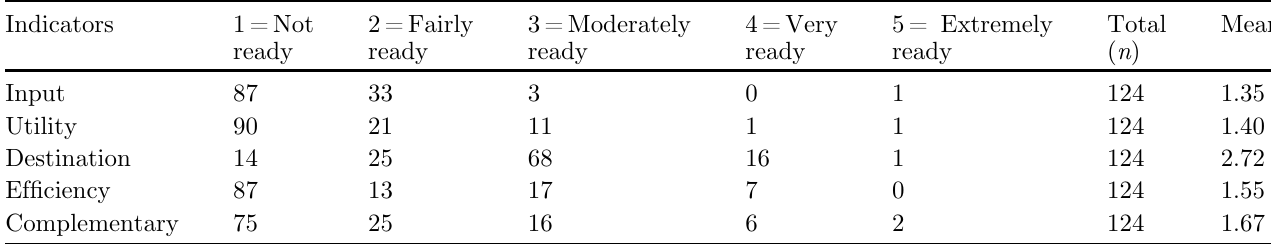
Table 4. Survey results on readiness for CE ( n =